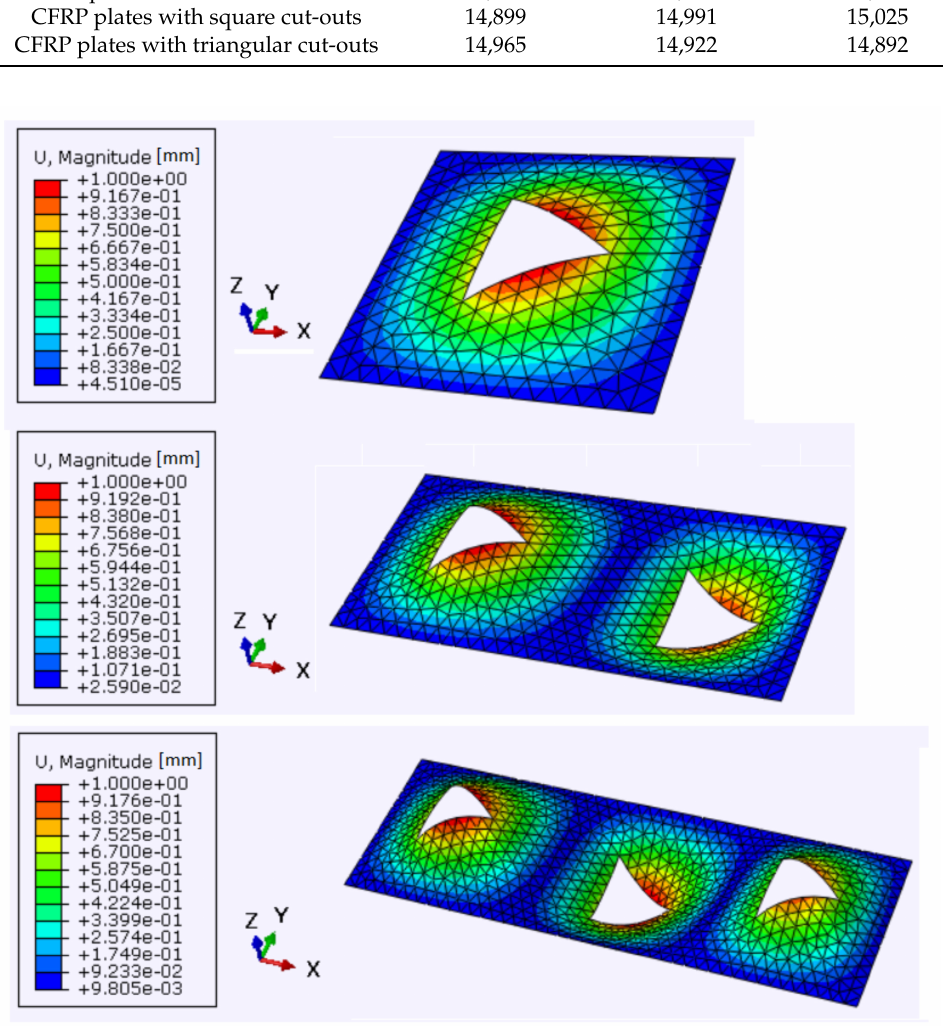
Figure 8. First buckling modes of plates with triangular cut-outs and their normalized displacement